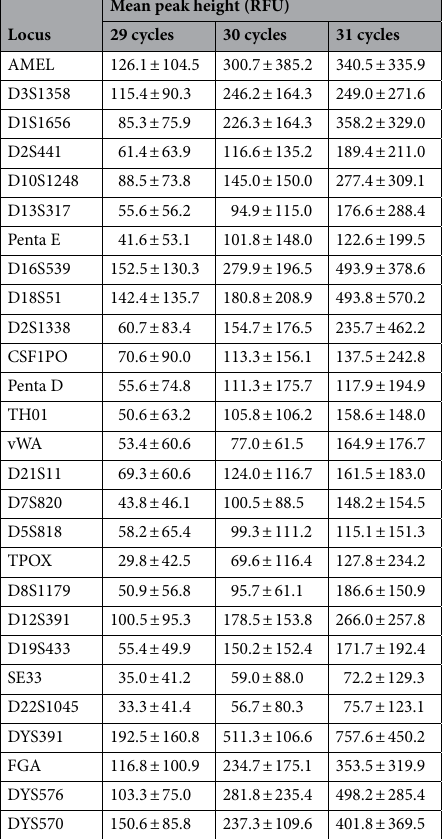
Table 1. Locus-specific mean peak heights for single cells amplified using 29, 30 and 31 cycles and the PowerPlex Fusion 6c human DNA amplification kit.